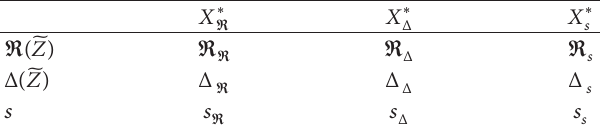
Table 1: The pay-off